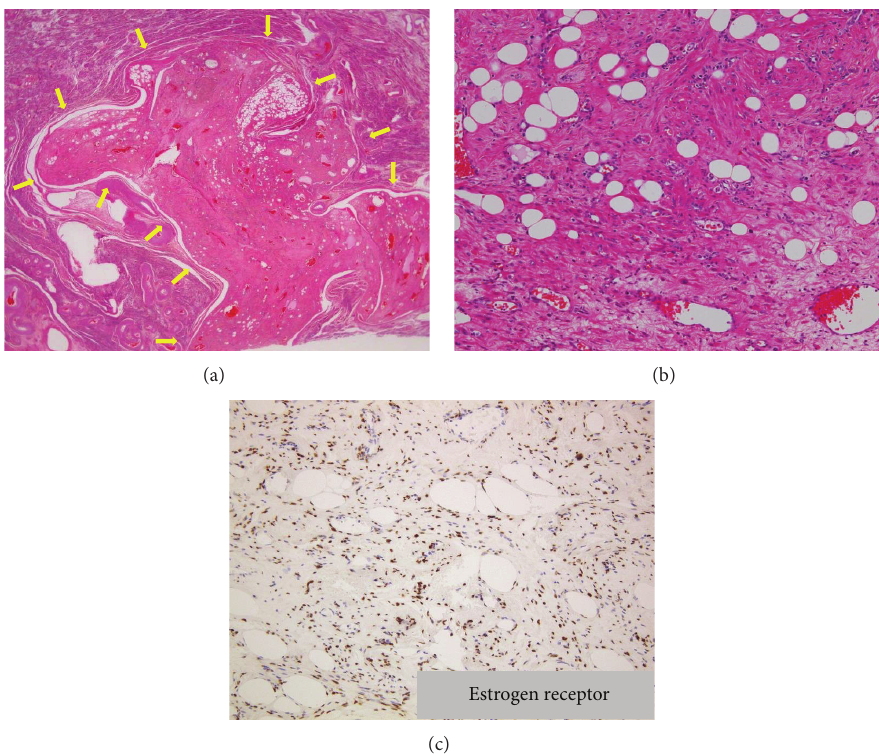
Figure 5: (a) HE staining showed the well-circumscribed uterine lesion protruding into the uterine myometrium (arrows). (b) The uterine lesion was composed of variable amounts of smooth muscle and fat cells with hydropic and hyaline degeneration, accompanied by numerous blood vessels. (c) On immunohistochemical staining, the nuclei of smooth muscle cells in the tumor were positive for estrogen receptor (ER) and progesterone receptor (PR) (not